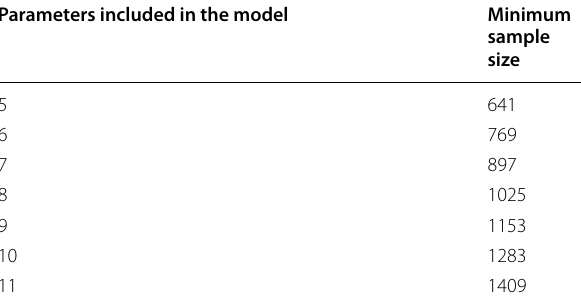
Table 2 Estimated minimum sample size for a range of parameters, for the overall survival model (also valid for the locoregional control and freedom from distant metastasis